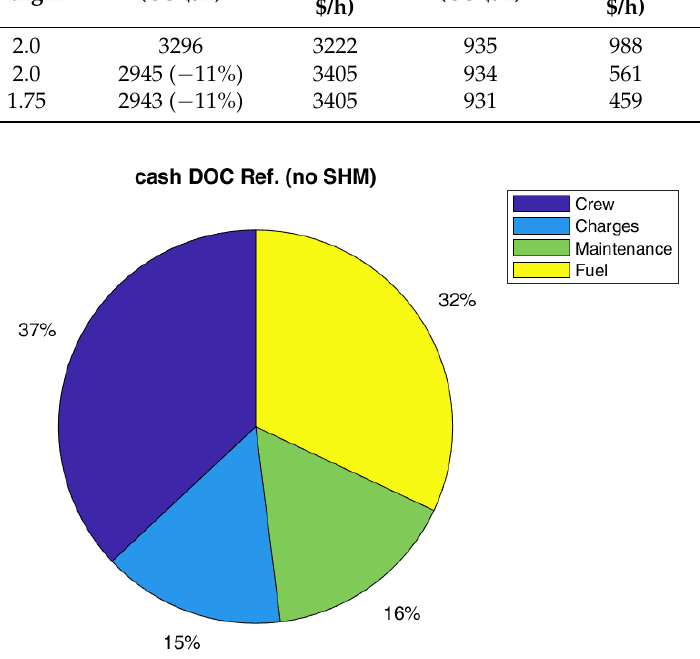
Figure 8. Pie chart of cash DOC for the Ref. configuration without SHM (SM = 2.0).